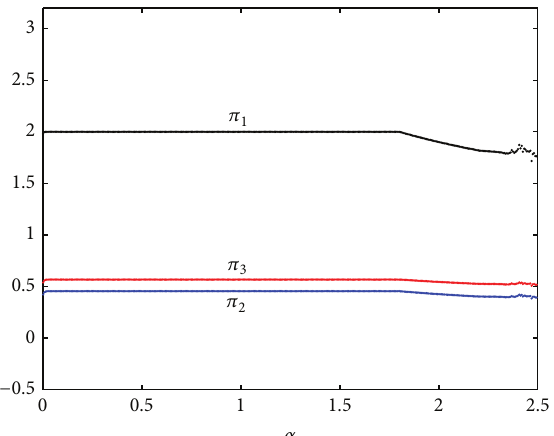
Figure 11: The long-run average profits of the players with 𝛼 for the controlled system (21).